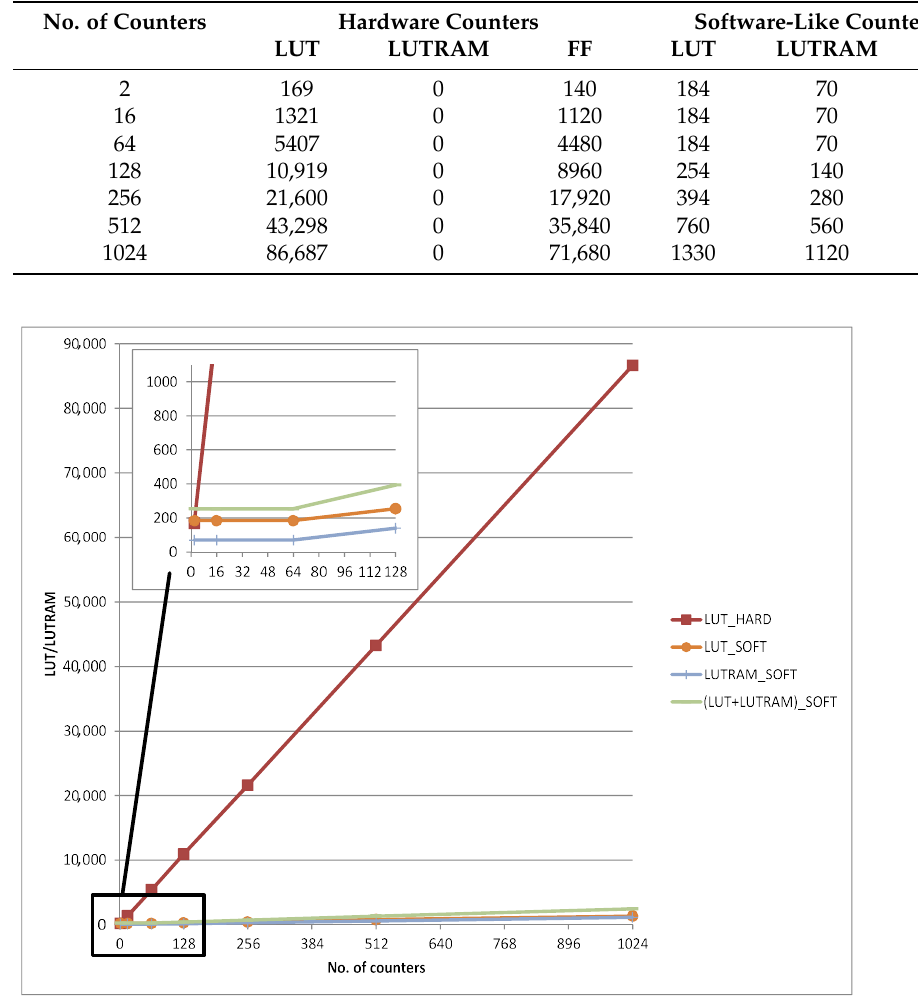
Figure 14. The comparison of the logic utilization for hardware and software-like